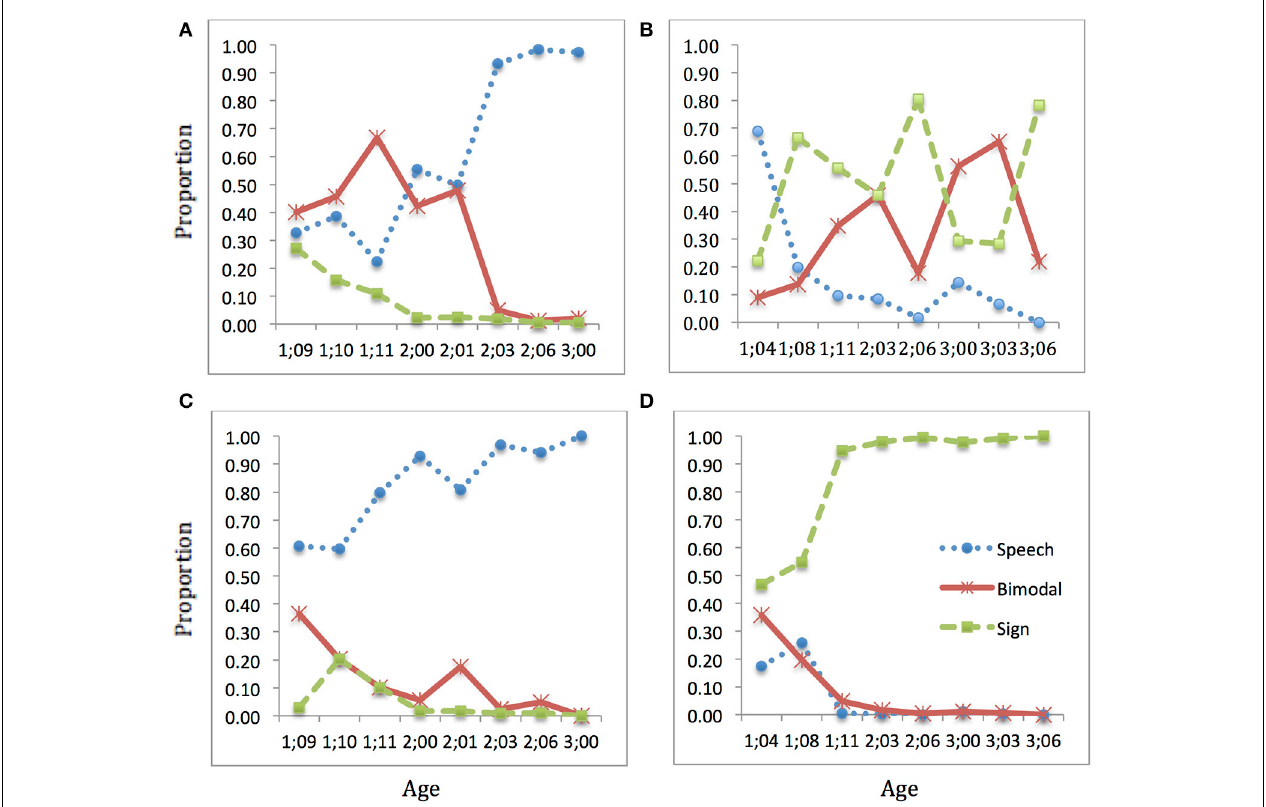
FIGURE 5 | Language choice over time: BEN. Proportion of speech (blue dotted), sign (green dashed), and bimodal (red solid) utterances produced: (A) child speech target; (B) child sign target; (C) interlocutor(s) speech target; (D) interlocutor(s) sign target (Note: Intervals along x-axis are not